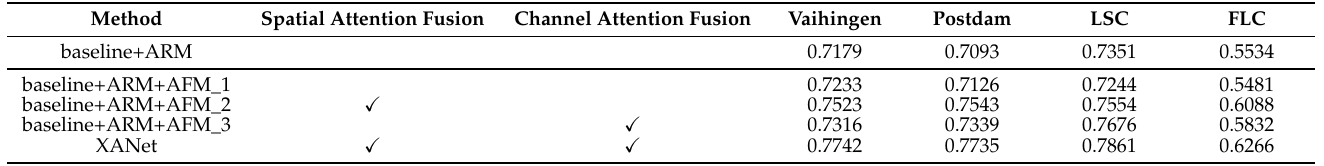
Table 8. Ablation studies of each component in